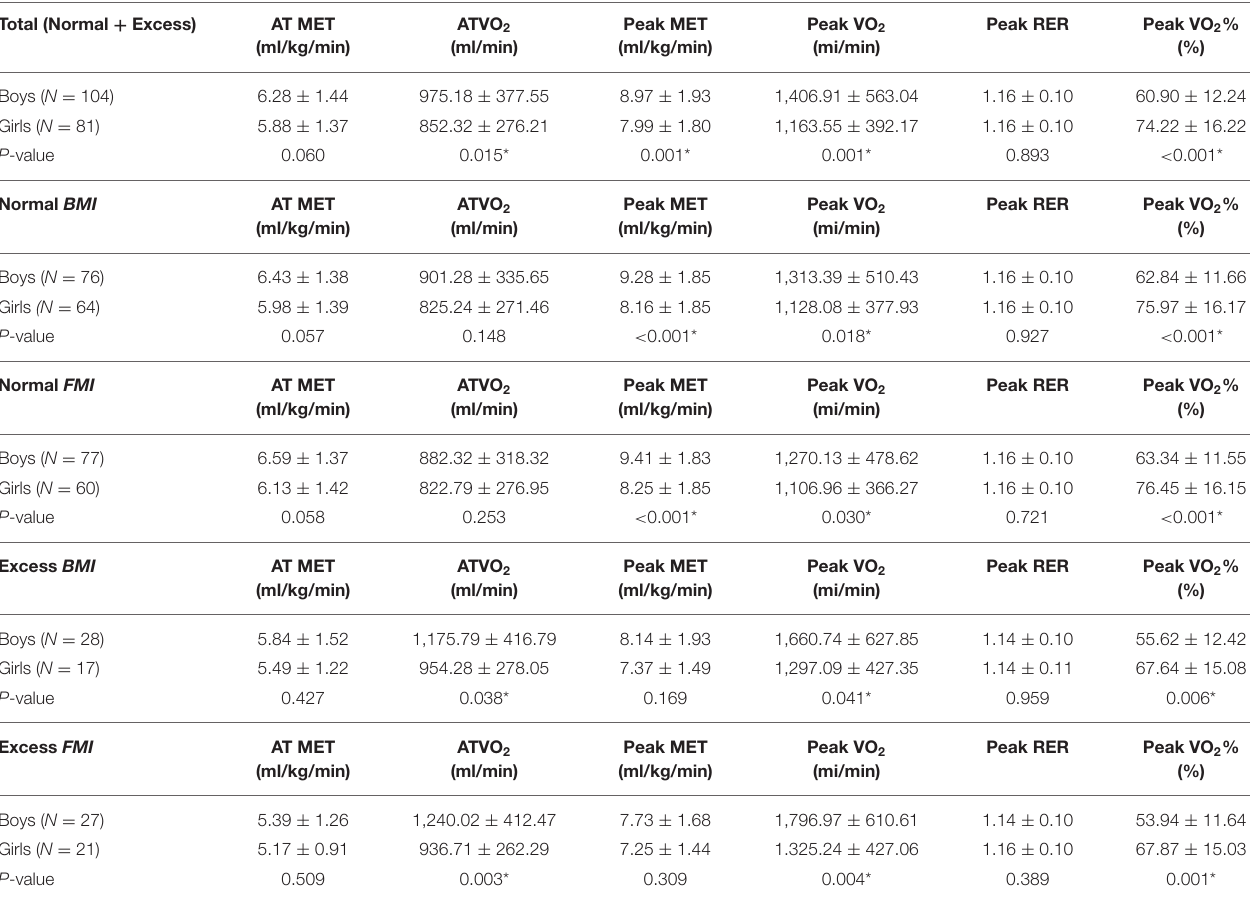
TABLE 5 | Comparisons of cardiopulmonary fitness between sexes with normal and excessive body adipose among patients with repaired tetralogy of fallot. Total (Normal + Excess) AT MET